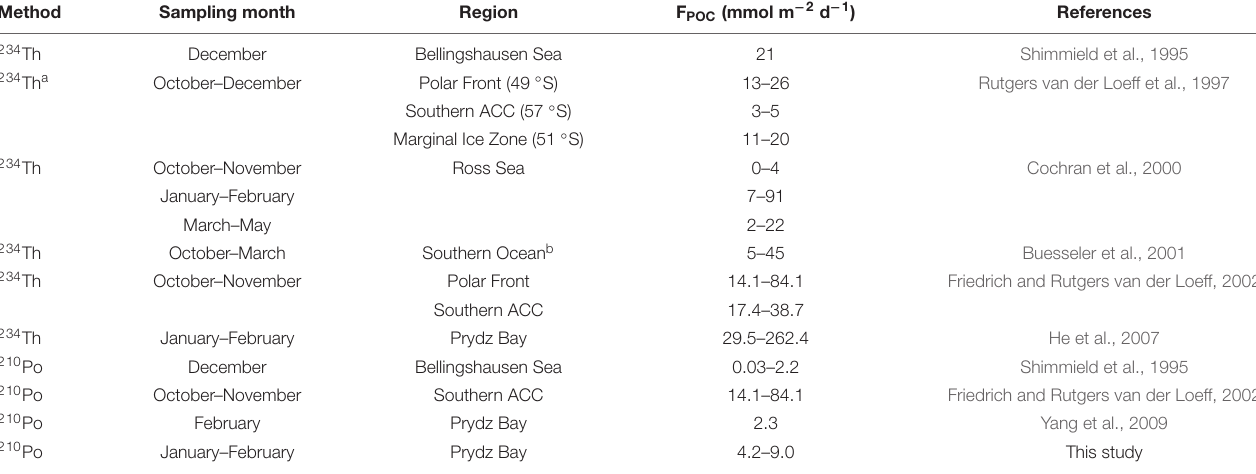
TABLE 3 | The POC export flux at a depth of 100 m in the Southern Ocean estimated from 234 Th/ 238 U to 210 Po/ 210 Pb disequilibria.